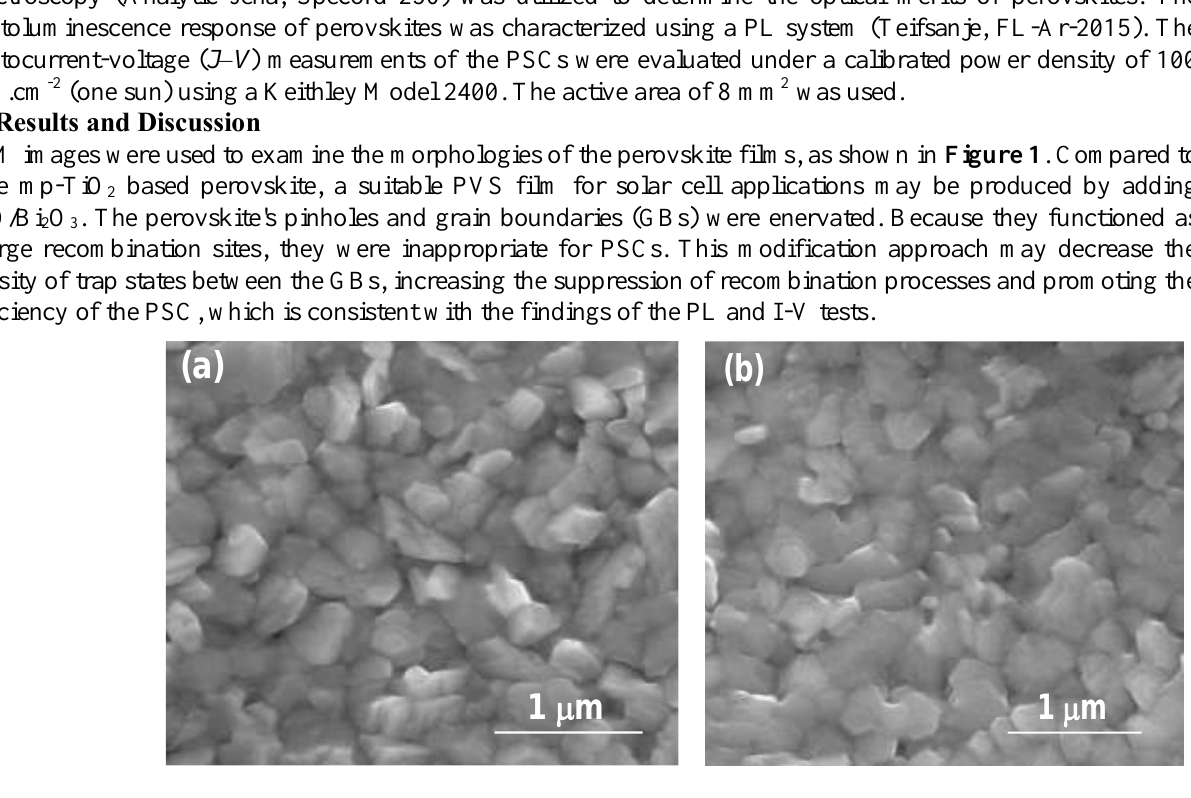
with (a) 0% rGO/Bi2O3 modified mp-TiO 2